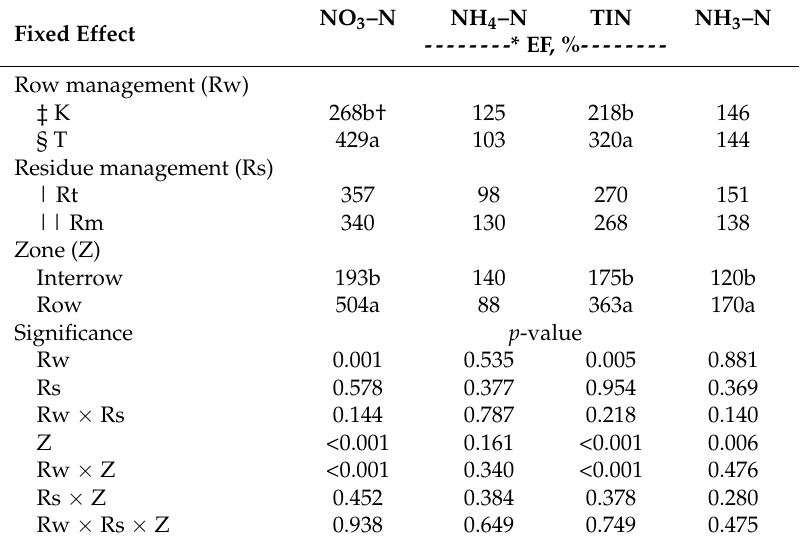
Table 3. Treatment means and significance of N pools following row